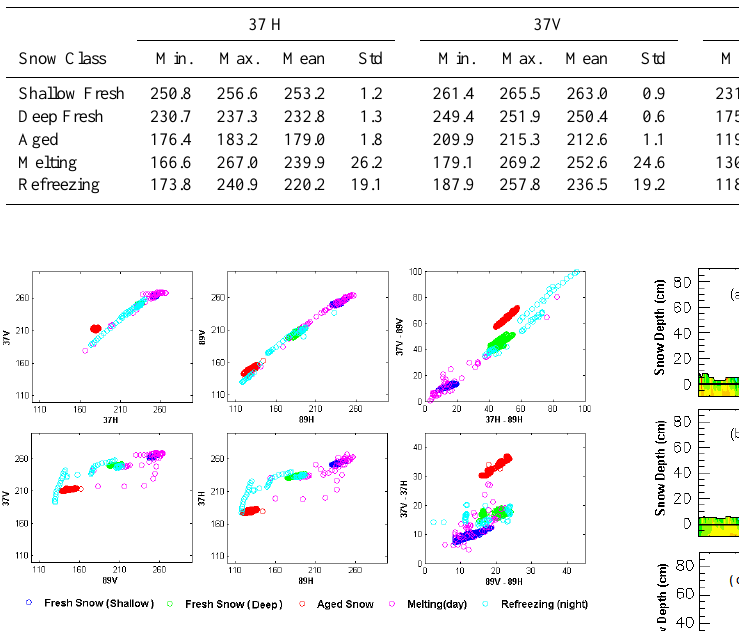
Fig. 6. Classification analysis of microwave observation for differ- ent snow conditions.